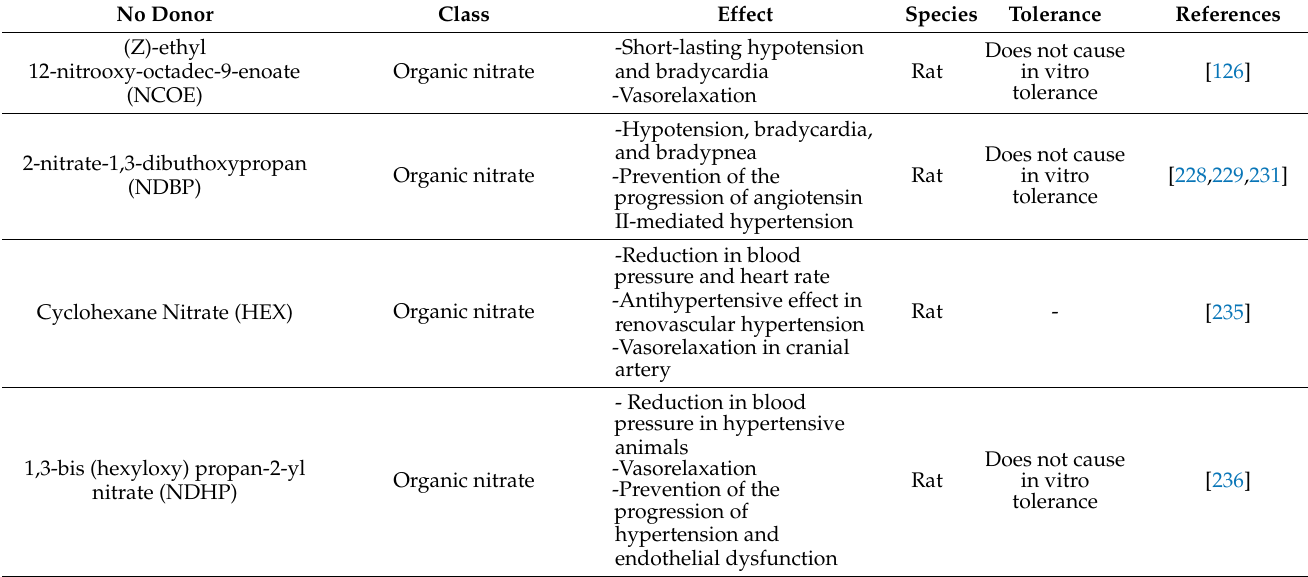
Table 2. New chemical classes of NO